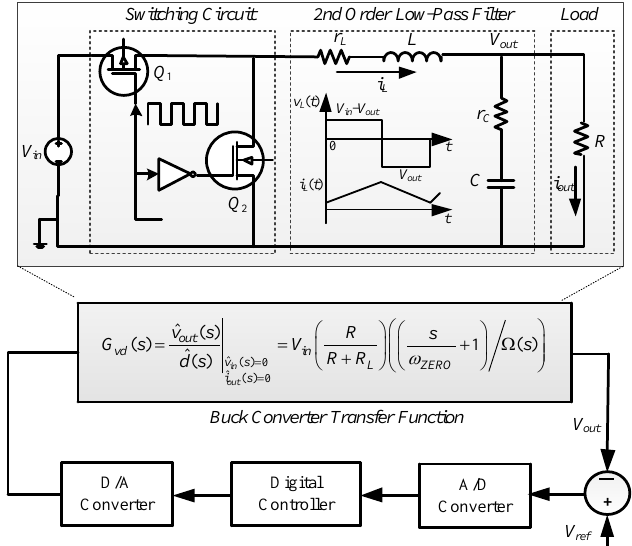
Figure 1. Closed-loop (digital) control system block diagram.